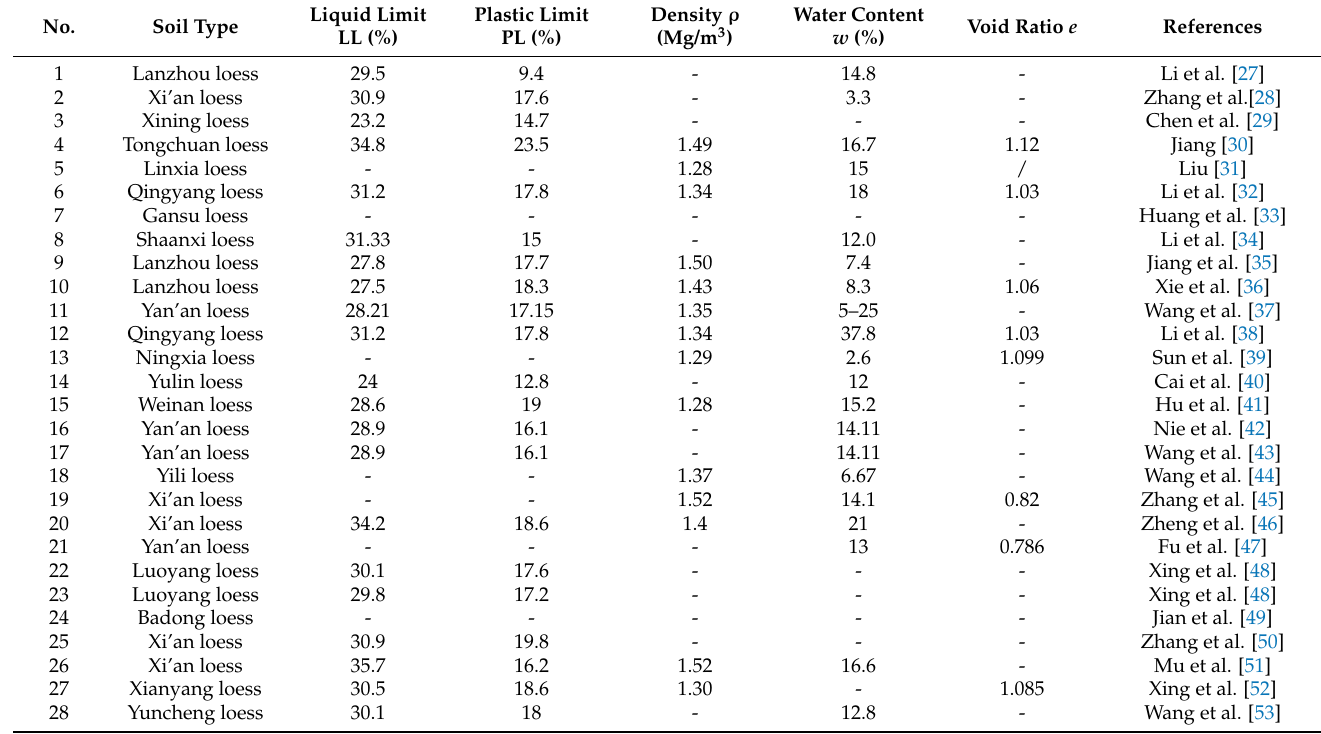
Table 1. Index properties of loess soil collected from the different